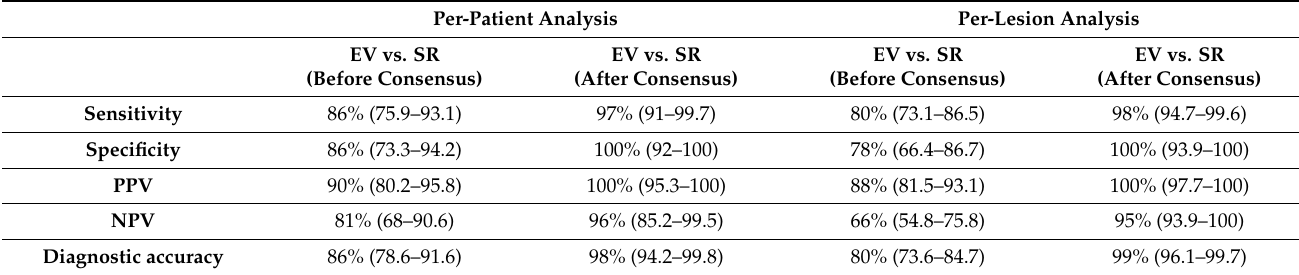
Table 2. Accuracy of Express View (EV) mode compared with standard reading (SR) before and after consensus review.